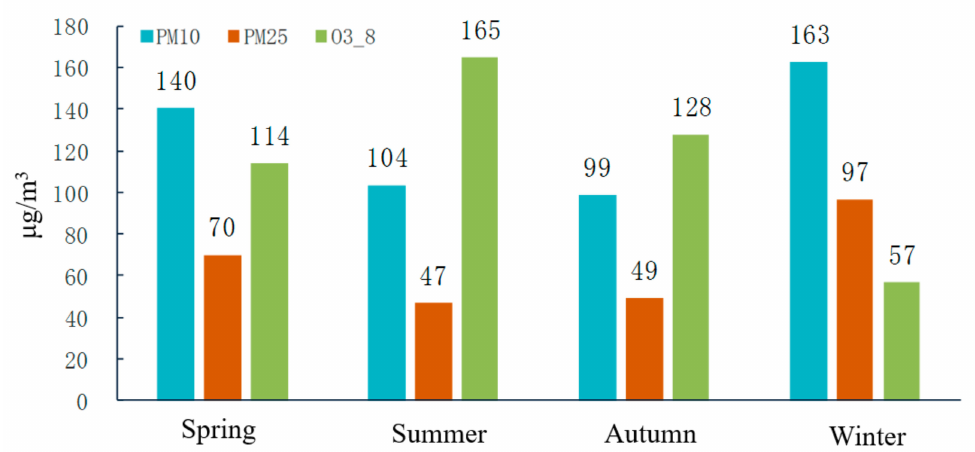
Figure 7. Seasonal concentration characteristics of the primary pollutants.